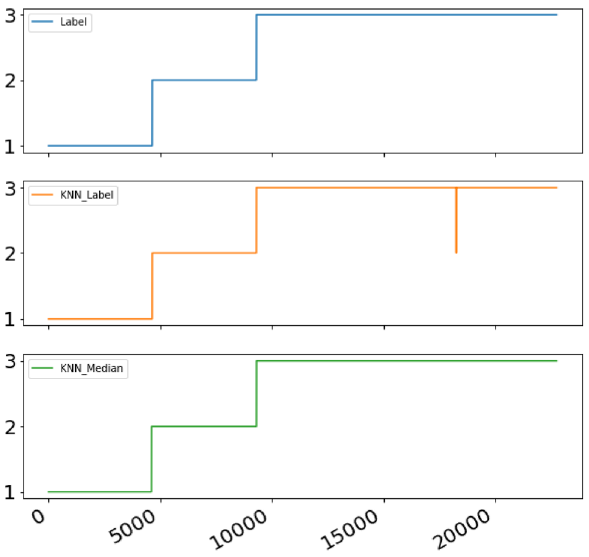
Fig. 10 Prediction from Case 5 (laboratory rig operations classifica- tion with raw- and median-filtered prediction)